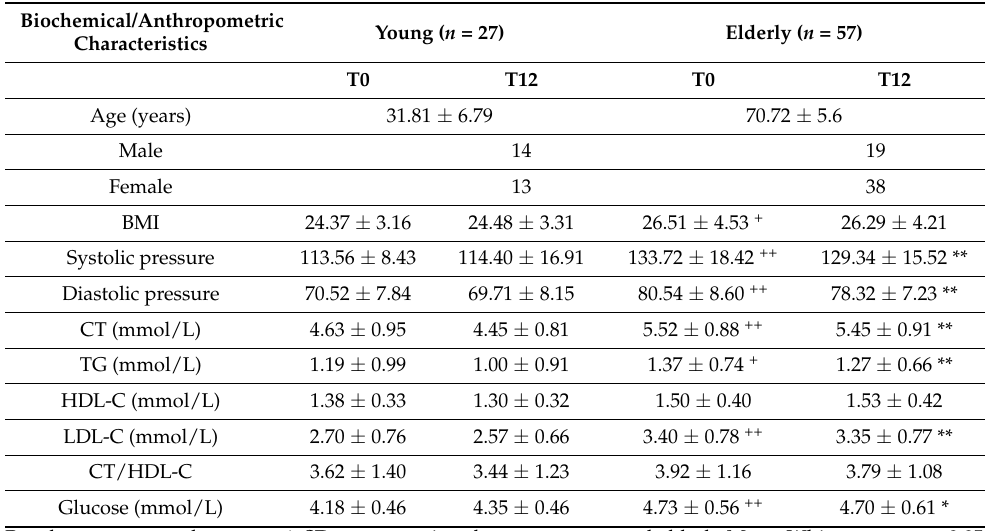
Table 1. Biochemical and anthropometric characteristics of the participants at recruitment and after 12 weeks of EVOO